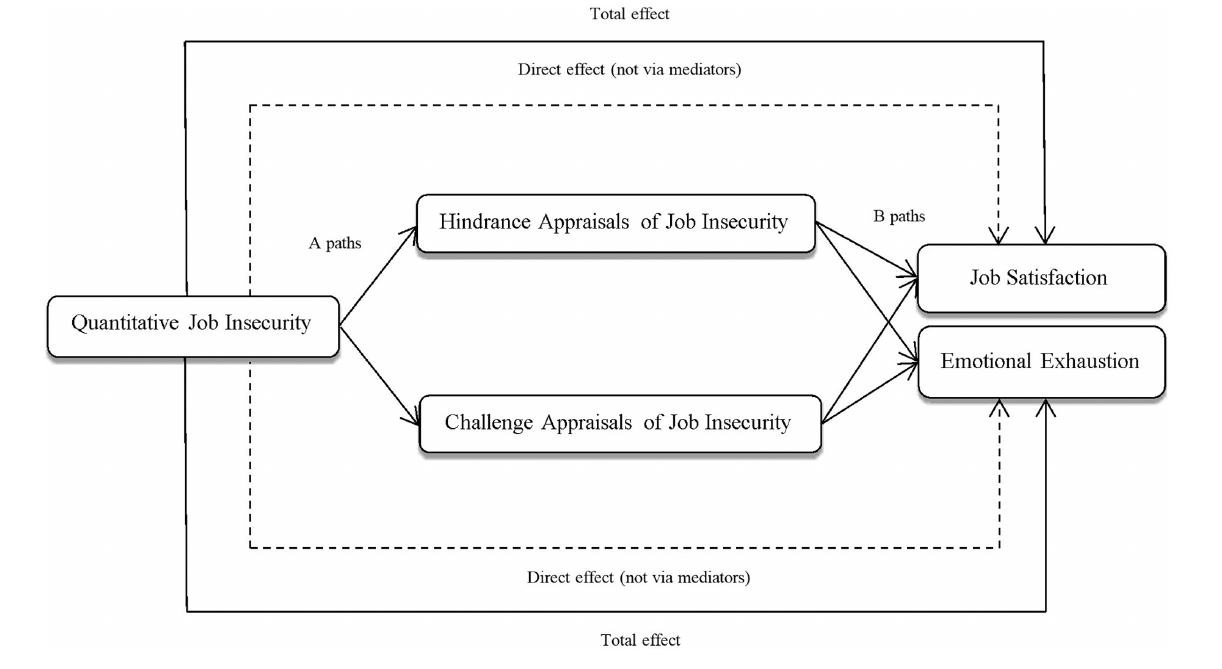
FIGURE 1 | A proposed model of the direct and in direct